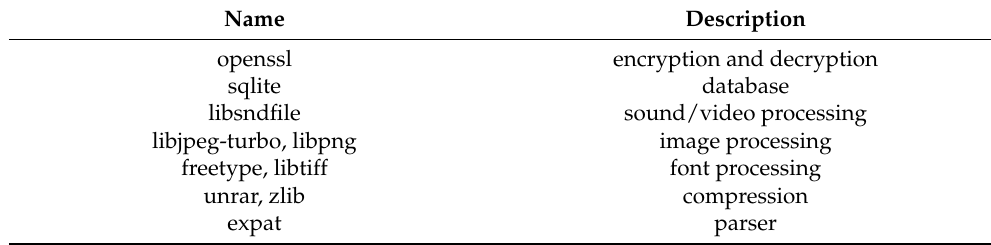
Table 4. Dataset II used for evaluation.